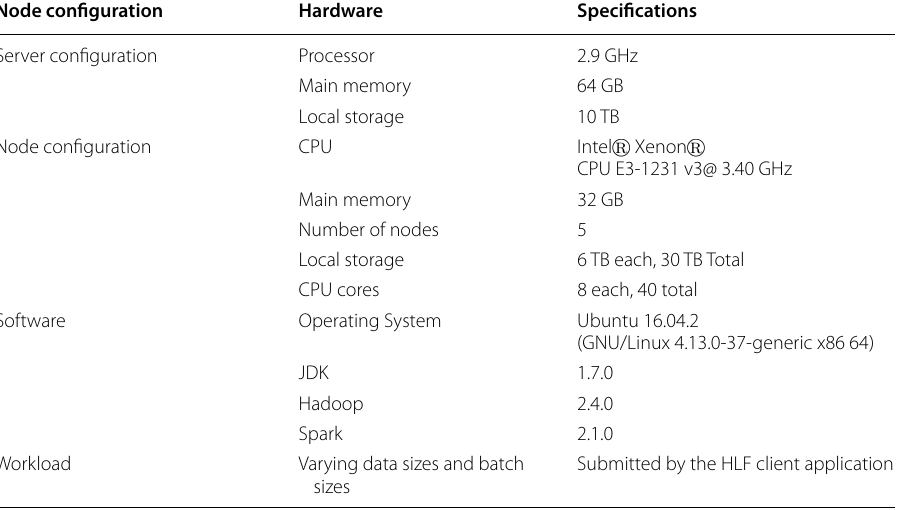
Table 2 Hadoop cluster experimental setup and